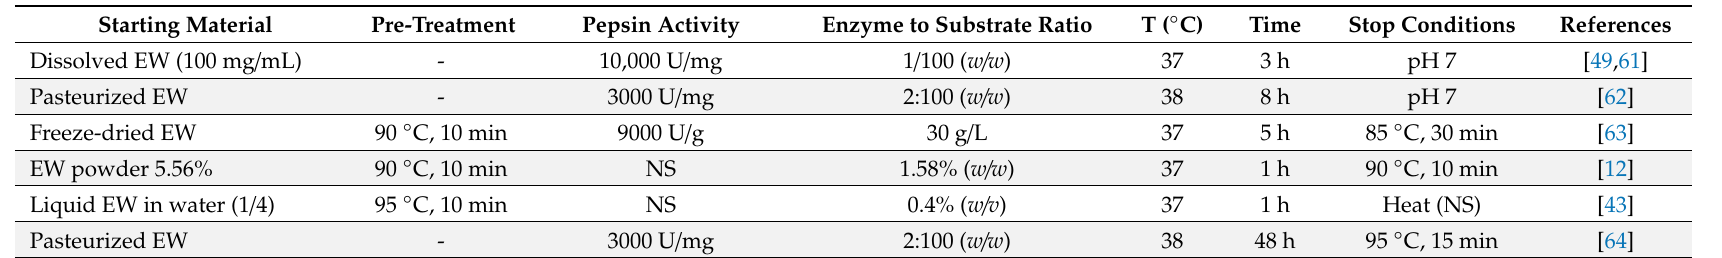
Table 2. Hydrolysis conditions applied to obtain antioxidant egg white hydrolysates using pepsin at pH